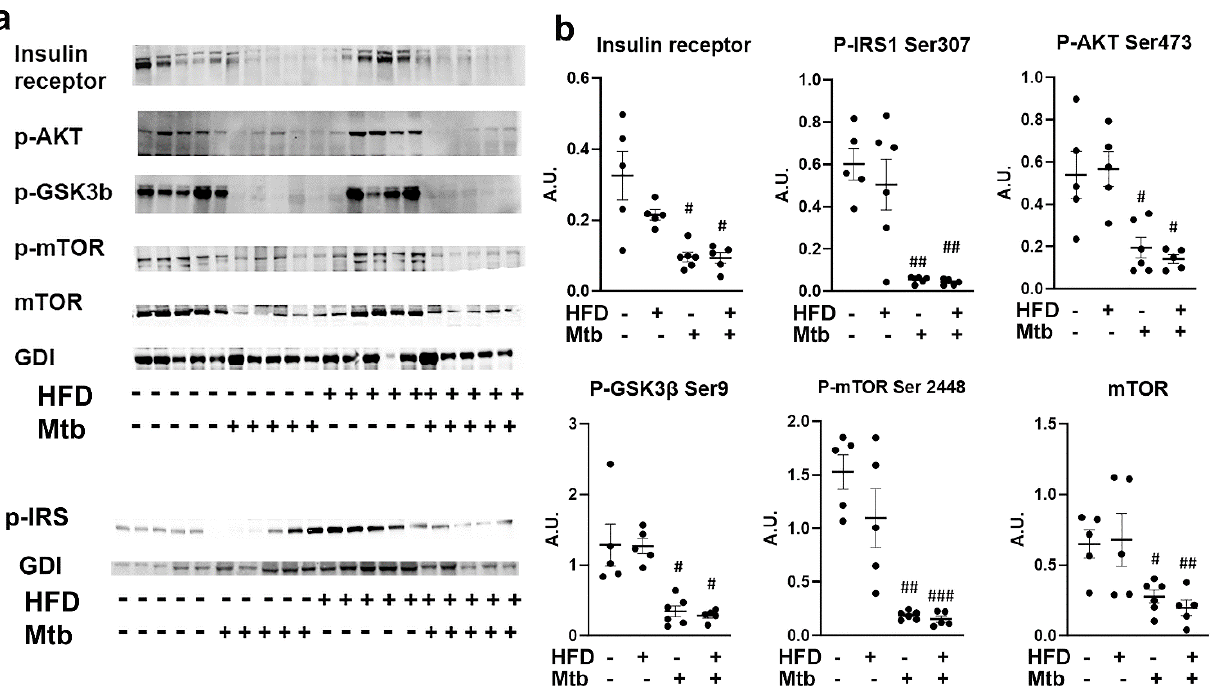
Figure 7. Impaired Insulin signaling in the lungs of Mtb infected adult mice ( a ) Immunoblot analysis of insulin receptor and insulin signaling proteins (p-IRS1 Ser307, p-AKT Ser473, p-GSK3 β Ser9, p-mTOR Ser2448, mTOR) in the lung lysates of infected and uninfected adult mice. GDI was used as loading control. ( b ) Fold changes in the protein levels were normalized to GDI expression and are represented as a dot plot. The error bars represent standard error of the mean. # p < 0.05, ## p < 0.01, and ### p < 0.001, compared to uninfected RD mice ( n = 5/group).